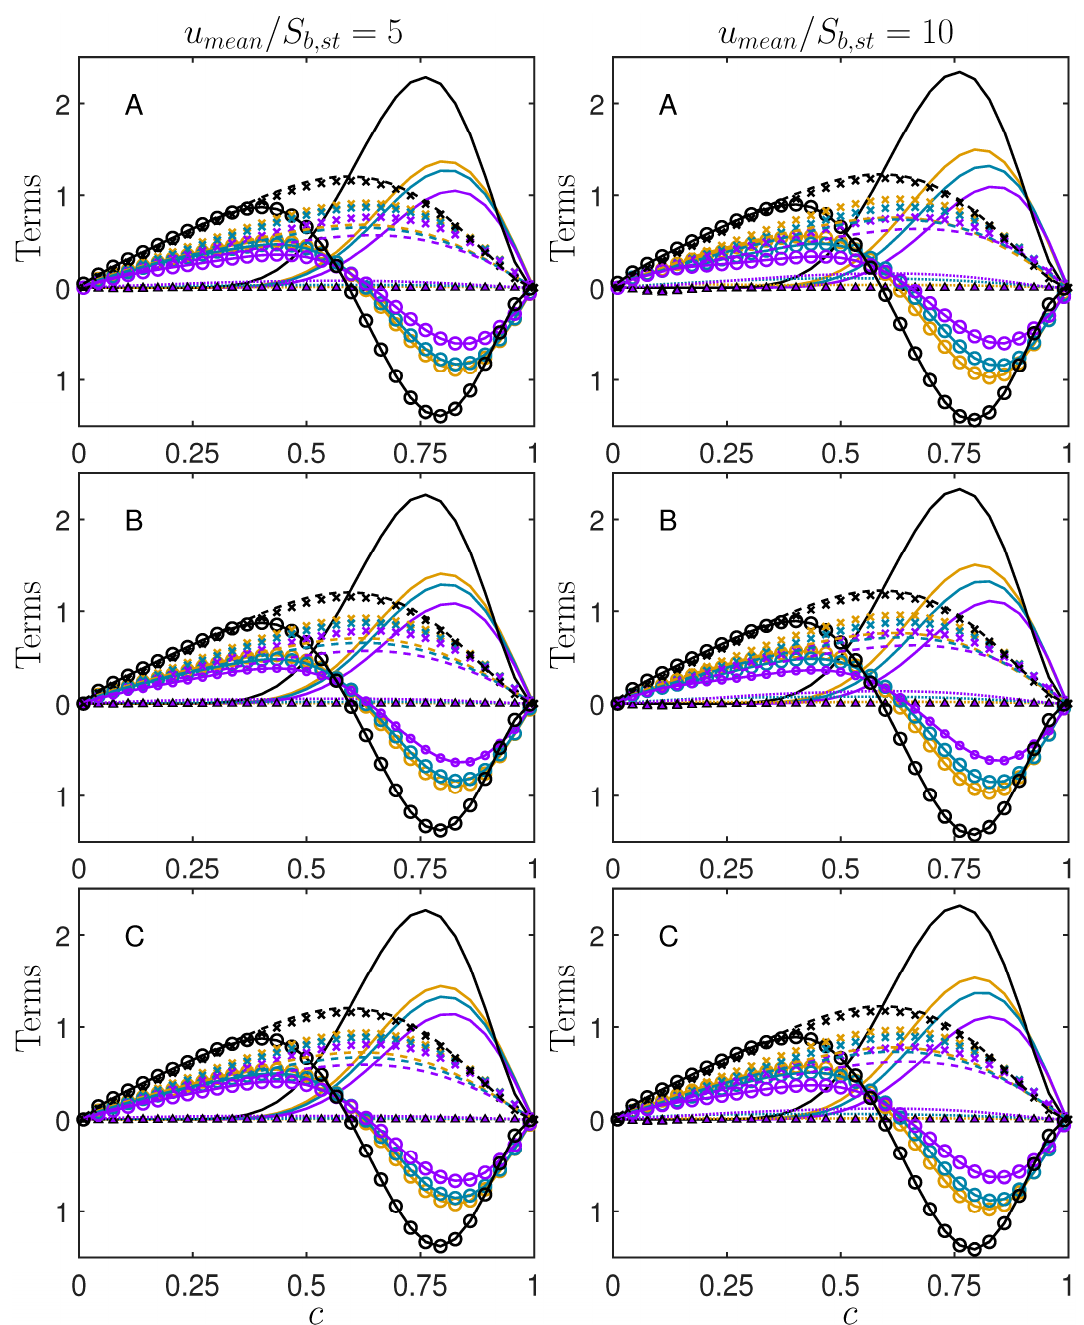
. . . Figure 9. Variations of mean values of 𝑤(cid:4662) (cid:3030) (solid line), ∇ ∙ (𝜌𝐷∇𝑐) (line with circle marker), 𝐴(cid:4662) (cid:3030) (dotted line), 𝑆(cid:4662) (cid:3039)(cid:3036)(cid:3044),(cid:3030) (triangle Figure 9. Variations of mean values of 𝑤(cid:4662) (cid:3030) (solid line), ∇ ∙ (𝜌𝐷∇𝑐) (line with circle marker), 𝐴(cid:4662) (cid:3030) (dotted line), 𝑆(cid:4662) (cid:3039)(cid:3036)(cid:3044),(cid:3030) (triangle w c (solid line), ∇· ( ρ D ∇ c ) (line with circle marker), A c (dotted line), S liq , c (triangle Figure 9. Variations of mean values of Figure 9. Variations of mean values of 𝑤(cid:4662) (cid:3030) (solid line), ∇ ∙ (𝜌𝐷∇𝑐) (line with circle marker), 𝐴(cid:4662) (cid:3030) (dotted line), 𝑆(cid:4662) (cid:3039)(cid:3036)(cid:3044),(cid:3030) (triangle Figure 9. Variations of mean values of 𝑤(cid:4662) (cid:3030) (solid line), ∇ ∙ (𝜌𝐷∇𝑐) (line with circle marker), 𝐴(cid:4662) (cid:3030) (dotted line), 𝑆(cid:4662) (cid:3039)(cid:3036)(cid:3044),(cid:3030) (triangle Figure 9. Variations of mean values of 𝑤(cid:4662) (cid:3030) (solid line), ∇ ∙ (𝜌𝐷∇𝑐) (line with circle marker), 𝐴(cid:4662) (cid:3030) (dotted line), 𝑆(cid:4662) (cid:3039)(cid:3036)(cid:3044),(cid:3030) (triangle marker), 𝜌𝑆 (cid:3031) | ∇𝑐 | (dashed line) and 𝜌 (cid:2868) 𝑆 (cid:3029),(cid:3046)(cid:3047) | ∇𝑐 | (cross) conditional on 𝑐 for premixed gaseous ( marker), 𝜌𝑆 (cid:3031) |∇𝑐| (dashed line) and 𝜌 (cid:2868) 𝑆 (cid:3029),(cid:3046)(cid:3047) |∇𝑐| (cross) conditional on 𝑐 for premixed gaseous ( marker), ρ S d | ∇ c | (dashed line) and ρ 0 S b , st | ∇ c | (cross) conditional on c for premixed gaseous ( marker), 𝜌𝑆 (cid:3031) |∇𝑐| (dashed line) and 𝜌 (cid:2868) 𝑆 (cid:3029),(cid:3046)(cid:3047) |∇𝑐| (cross) conditional on 𝑐 for premixed gaseous ( marker), 𝜌𝑆 (cid:3031) |∇𝑐| (dashed line) and 𝜌 (cid:2868) 𝑆 (cid:3029),(cid:3046)(cid:3047) |∇𝑐| (cross) conditional on 𝑐 for premixed gaseous ( marker), 𝜌𝑆 (cid:3031) |∇𝑐| (dashed line) and 𝜌 (cid:2868) 𝑆 (cid:3029),(cid:3046)(cid:3047) |∇𝑐| (cross) conditional on 𝑐 for premixed gaseous